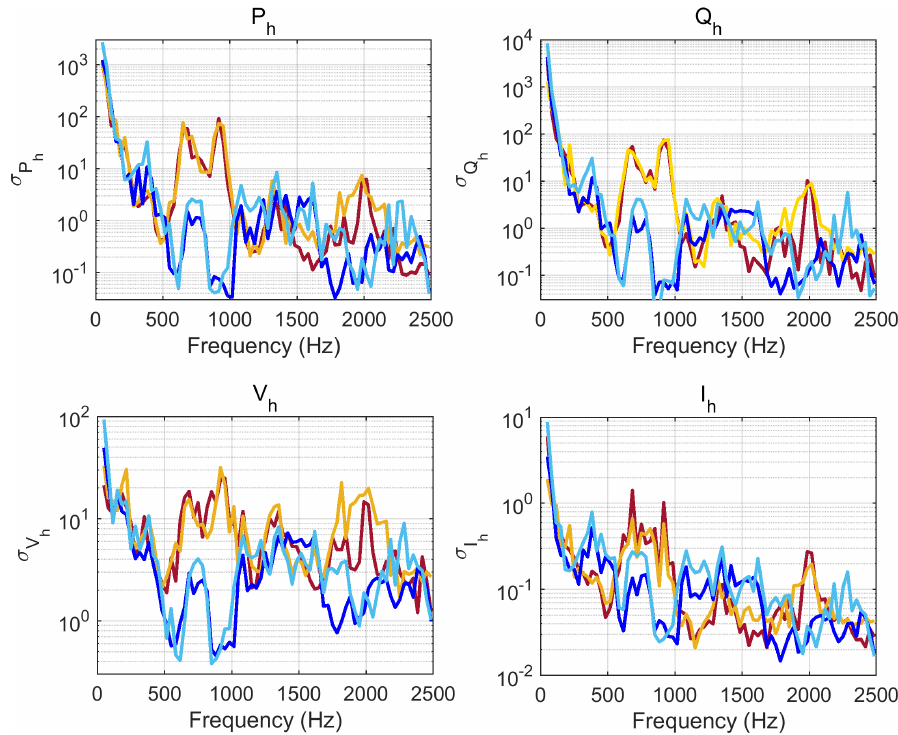
Figure 12. Dispersion σ , calculated out of 24 + 24 observations for traction (dark colors) and braking (light colors) conditions: CH brown, D